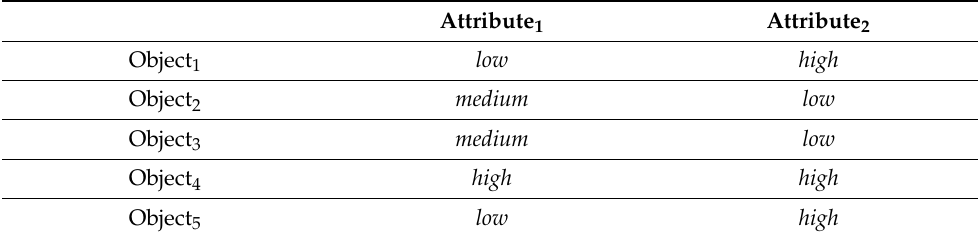
Table 3. Sample information system with five objects and two